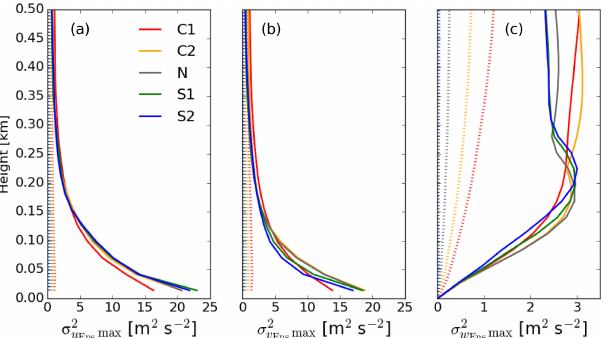
Figure 11. Profiles of the maximum u , v , and w variance of the en- semble mean in panels a, b, c) , respectively, for each case. In each plot, for a given height, the maximum ensemble variance is com- puted over a specific time interval. In the case of the environment (dotted lines), the first 3min of the output are considered, whereas, in the case of the downbursts, the first 13min are utilized for the